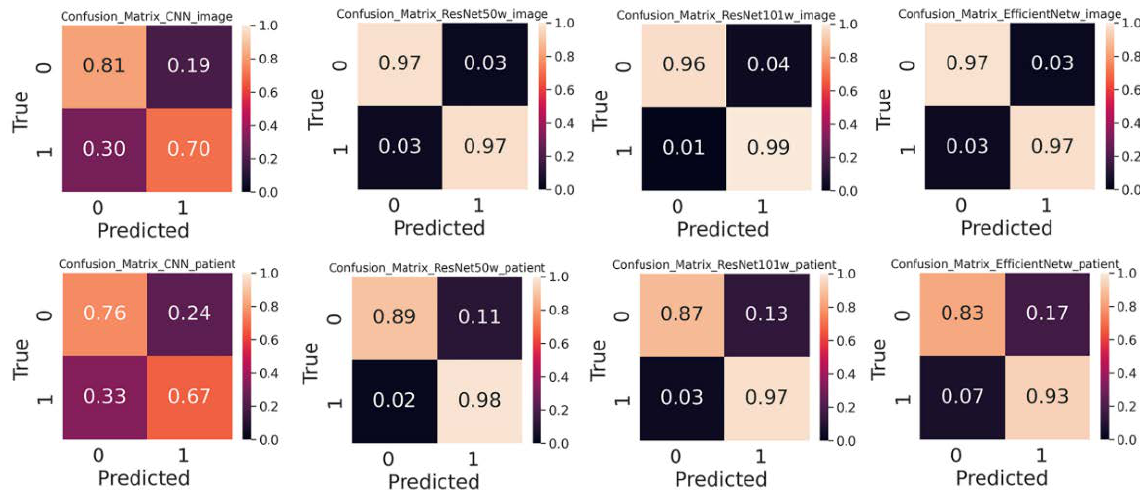
Figure 7. Confusion matrix of each model on the test dataset using image and patient-level splitter.